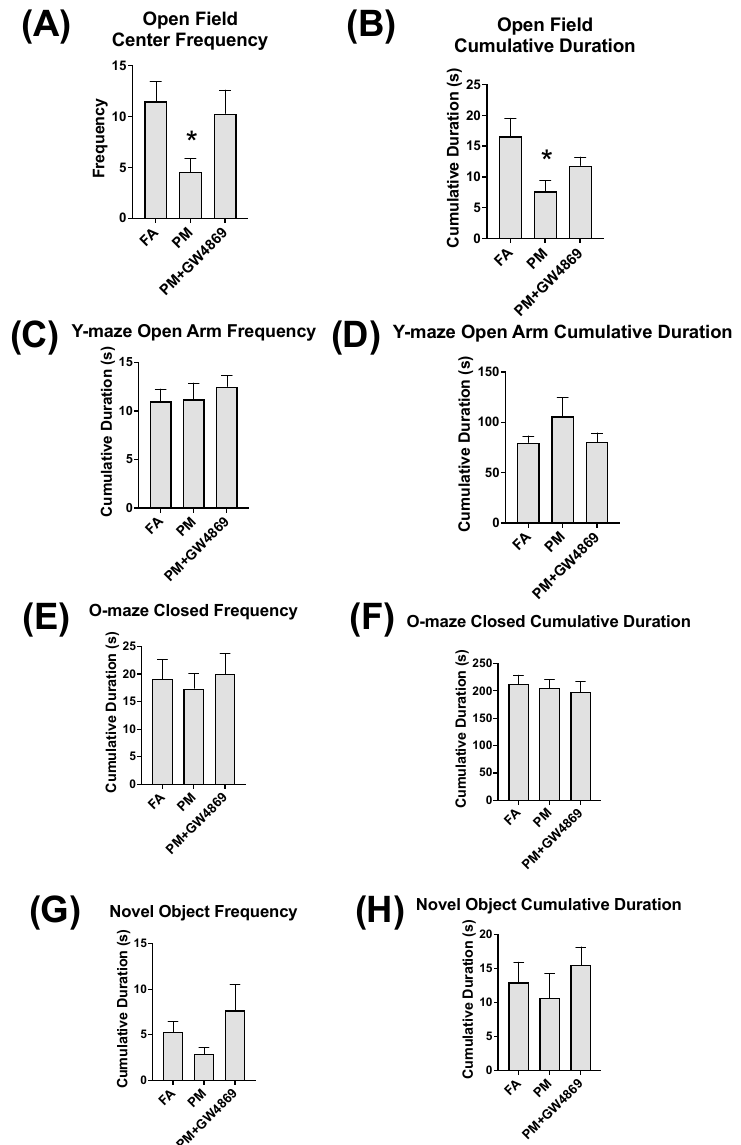
Figure 5. Behavioral tasks. Behavioral tasks were executed following FA, PM, and PM + GW4869 aspiration. These included the open-field test ( A , B ), Y-maze ( C , D ), O-maze ( E , F ), and novel object test ( G , H ). The open-field test resulted in significantly diminished center frequency visitation ( p = 0.0482) and open-field cumulative duration ( p = 0.0407). Data represent the mean ± SEM. Data are considered significant at p ≤ 0.05, as indicated by the asterisk (*).